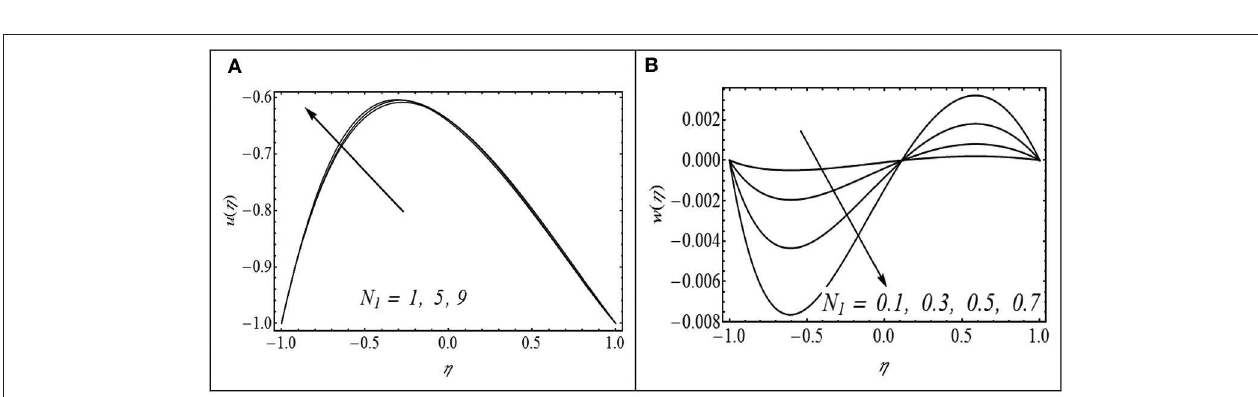
FIGURE 3 | (A,B) Impact of N 1 on u (η) with γ = 2.5, Ha = 2, N 2 = 0.2, λ = 0.4, and 2 = 1.5. (B) Impact of N 1 on w (η) with γ = 2.5, N 2 = 0.2, λ = 0.4, and 2 = 1.5.